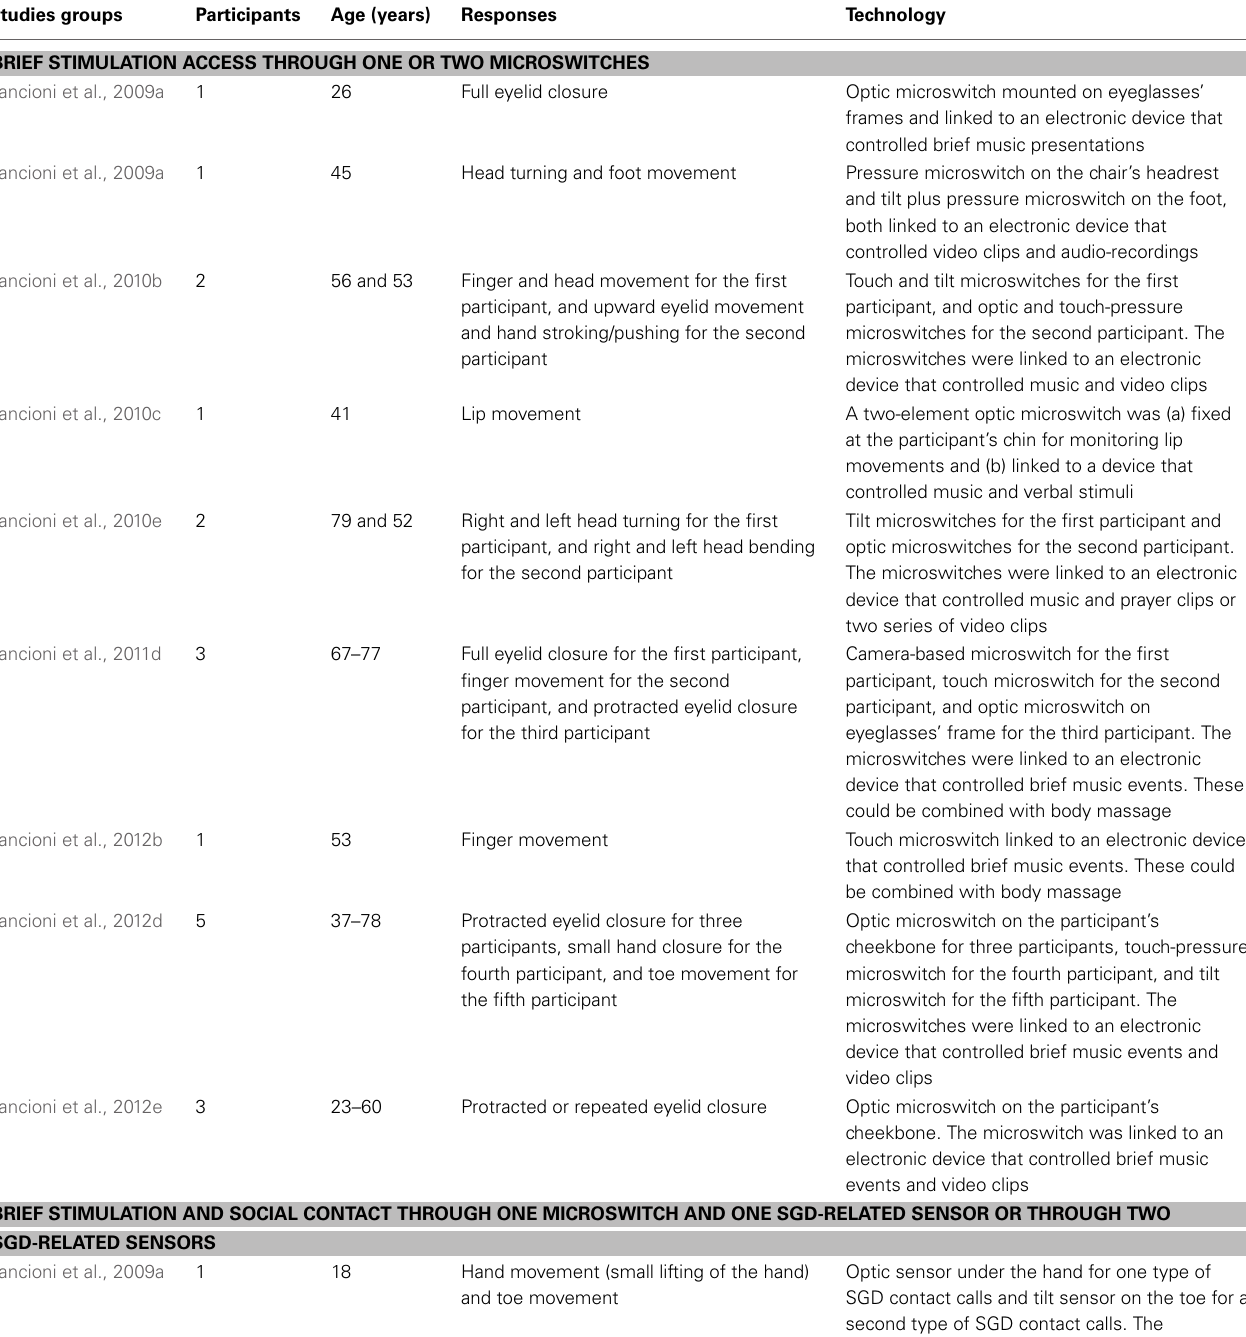
Table 1 | List of studies using technology-aided intervention programs to promote stimulation control and communication in post-coma